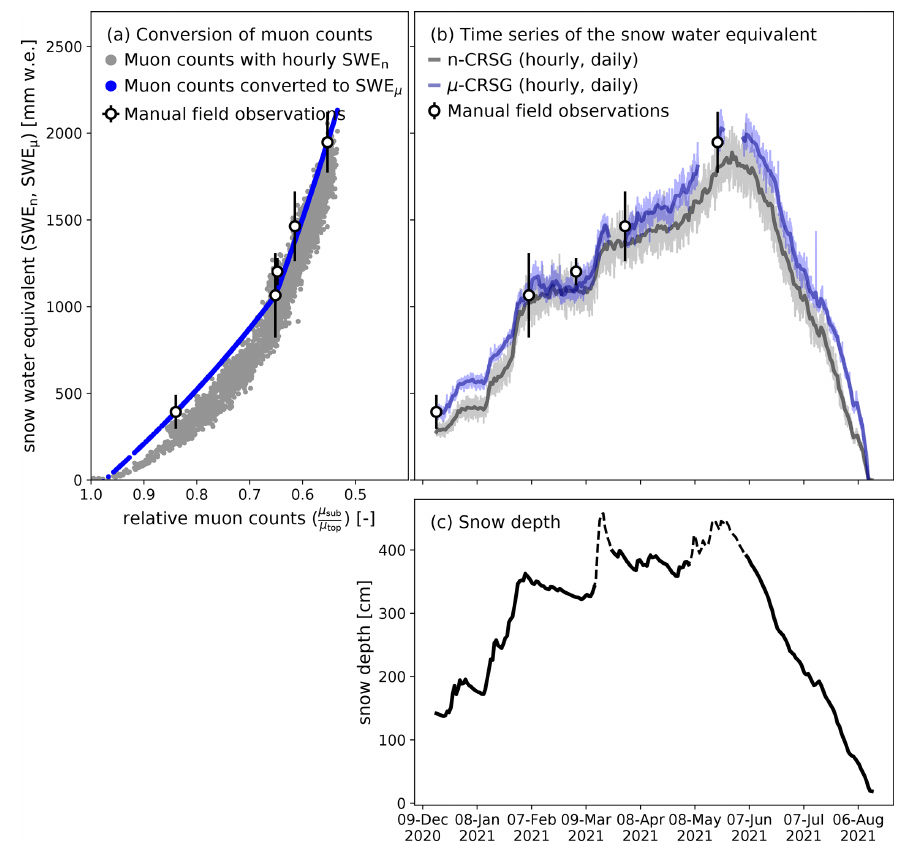
Figure 3. From muon count rates to SWE. Panel (a) shows the relative muon count rates plotted against SWE that is measured by the n-CRSG (grey dots) and measured manually (white dots). Blue dots represent the SWE that is directly inferred from the relative muon count rate with the conversion function given in Eq. (6). Panel (b) shows the time series of SWE inferred from neutron counts (grey) and muon counts (blue) at a daily resolution. Light grey and light blue represent hourly observations of the n-CRSG and µ -CRSG, respectively. Panel (c) shows snow depth measured at the site (solid line) with data gaps that were complemented from a nearby high-altitude station (dashed line).